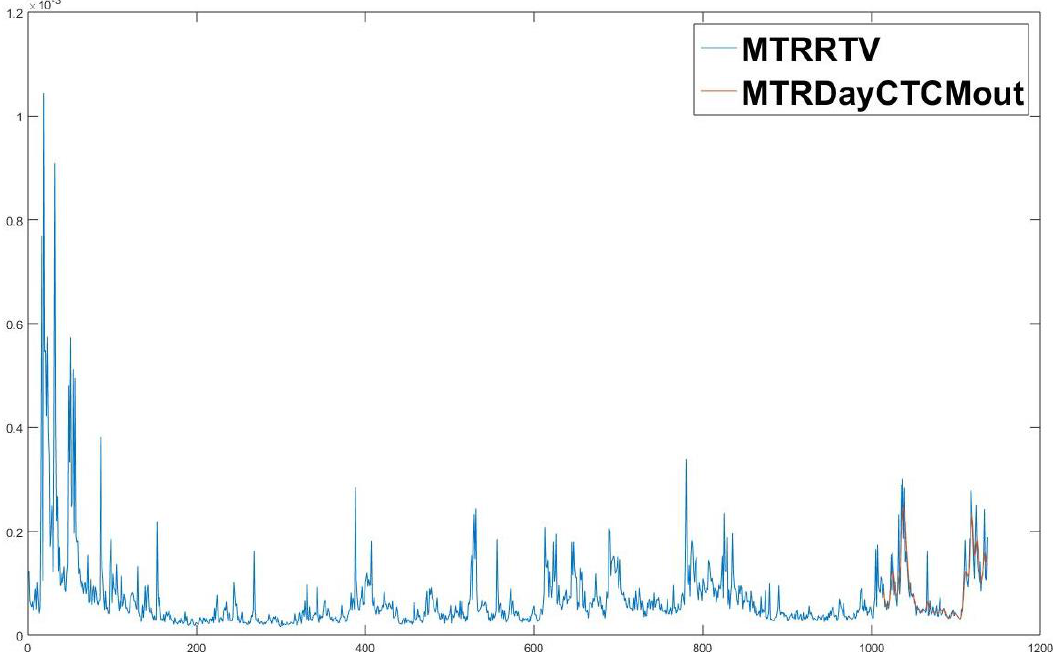
Figure 6. Model CTCM-RTV-D Forecast for MTR. The horizontal line is the timeline, and the perpendicular line is the volatility estimator. The forecasted period is the last 124 days. The actual values are represented by the blue line, while the forecasted values are represented by the orange line. The forecasted values are closed to the actual values, except for a sharp jump around the Day